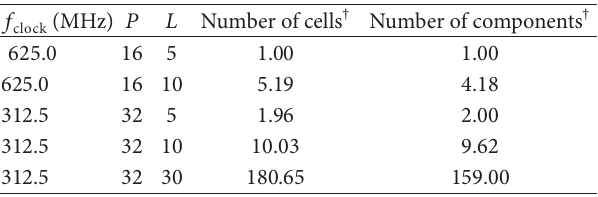
Table 4: Synthesis results for parallel DFFE architecture for 2 -PAM and 𝑅 = 𝐿 + 1 with 28nm CMOS